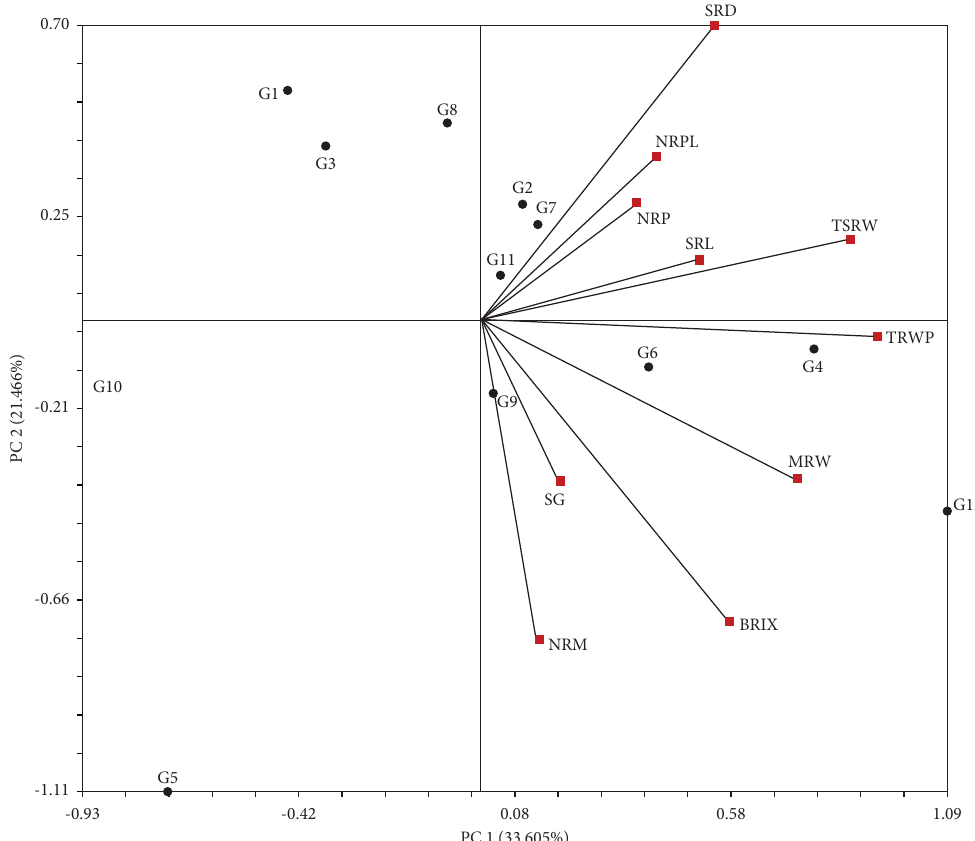
Figure 1: Distribution pattern of nine genotypes PFSP and three commercial varieties as checks based on ten agronomic traits in Cilembu